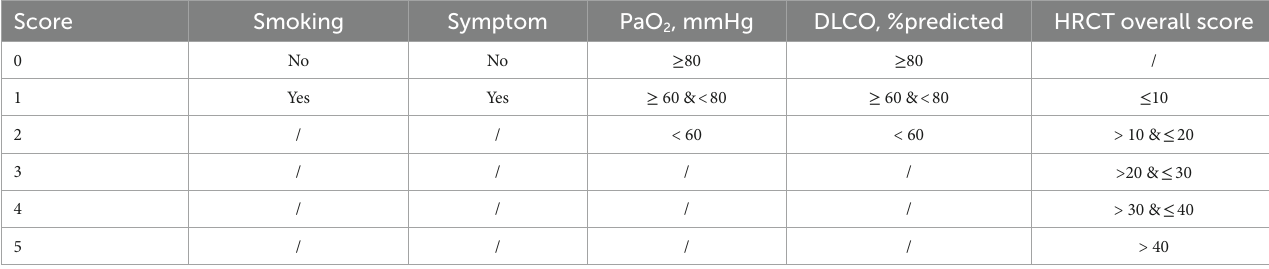
TABLE 2 Scoring Standards in